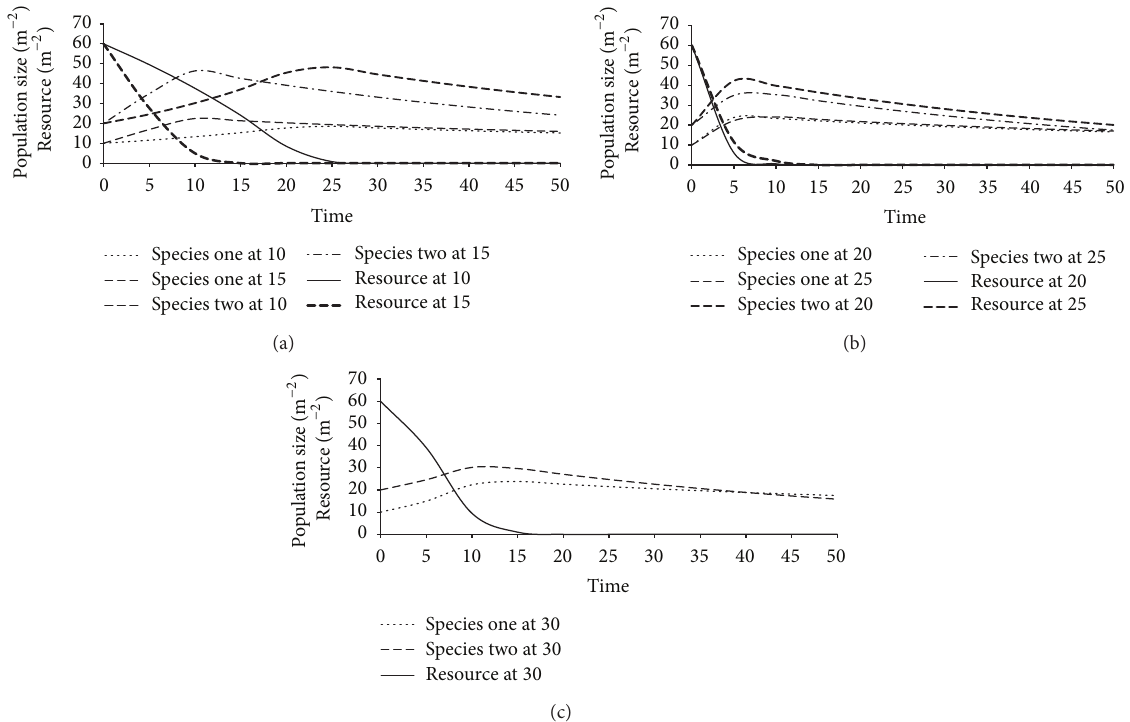
Figure 5: Behavior of the isoclines when the population size of species two is greater than species one; curves (a)–(c) show the behavior of population size for each species and the resource at temperatures: (a) 10 ∘ C and 15 ∘ C, (b) 20 ∘ C and 25 ∘ C, and (c) at 30 ∘ C,